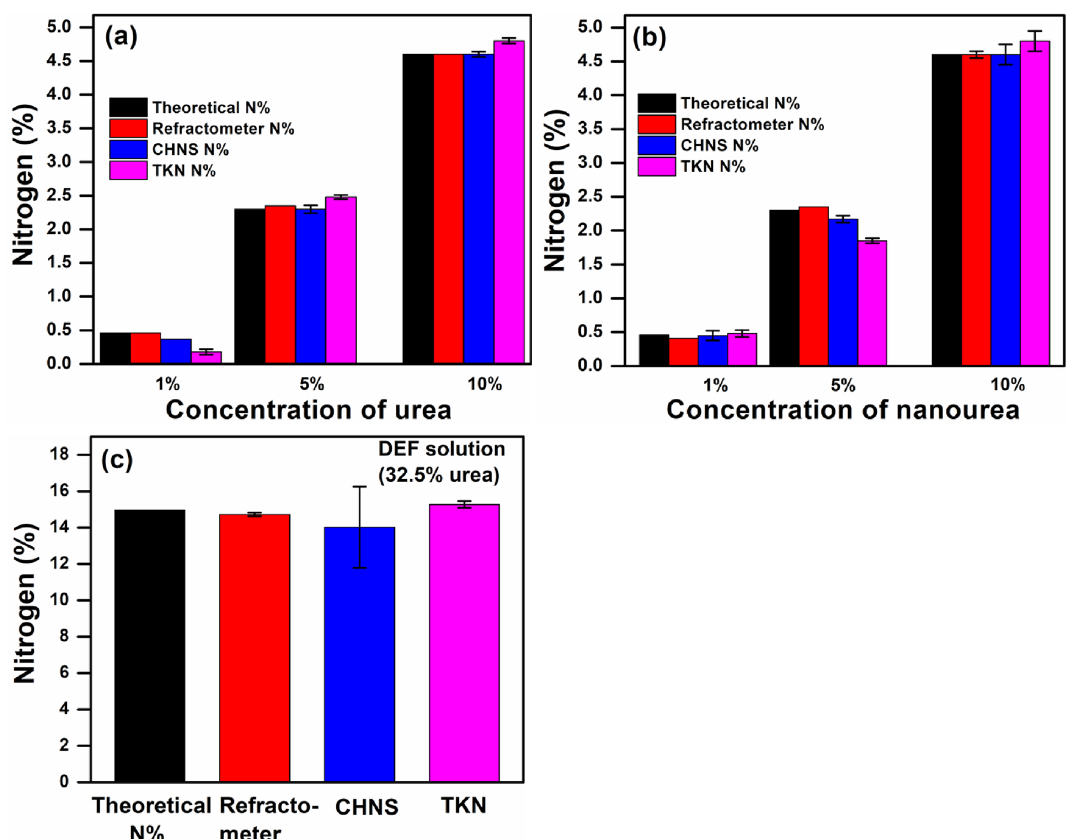
Figure 4. N% detection by using different techniques and their comparison with the theoretical value of different concentration of ( a ) urea and, ( b ) nano urea ( c ) estimation of N% in DEF solution containing 32.5% urea by using different methods (refractometer, CHNS, and TKN) and compared with theoretical value of N%. (Refractometer based device showed less deviation ~ 1.53% with theoretical value as compared to other techniques in case of DEF